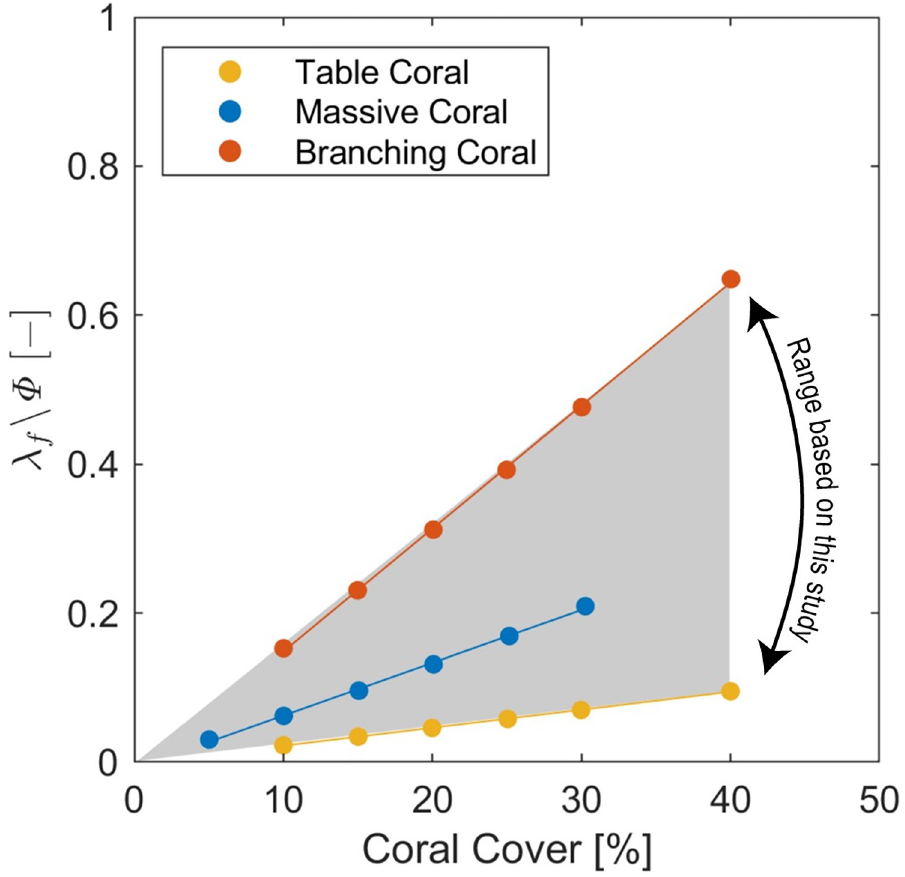
Fig 7. The allometric relationship between coral cover and the resultant value of λ f / ϕ for three archetypal benthos colony forms (“table”, “massive” and “branching”) which are based on observations of the representative species Acropora hyacinthus [15], Porites lobata [15] and Pocillopora edyouxi [16], respectively. The markers indicate data from the numerical simulations. The shaded area roughly represents the range of typical values based on the results of this